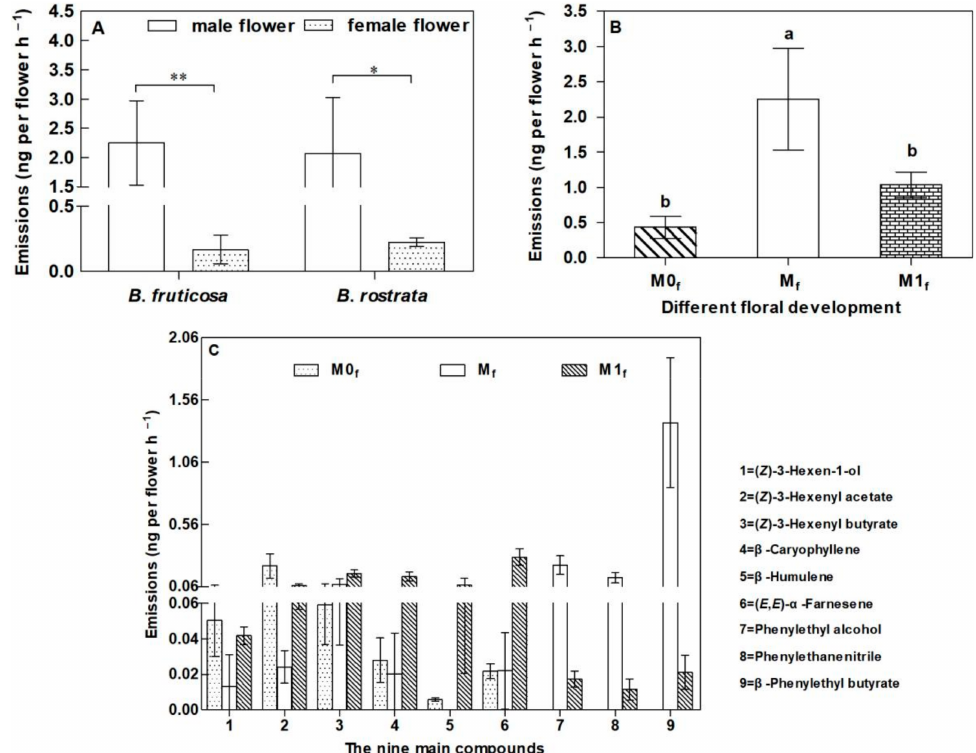
Figure 5. Total emission of scent compounds from male and female flowers of two Breynia species studied: ( A ) male and female flowers of two Breynia species studied at pollination stage, * and ** indicated respecitively significant p values ( p < 0.05) and extremely significant p values ( p < 0.01); ( B ) male flowers of B. fruticosa during different floral development stages; ( C ) the nine main com- pounds from male flowers of B. fruticosa during different floral development stages, The different lowercase showed significant p values ( p <